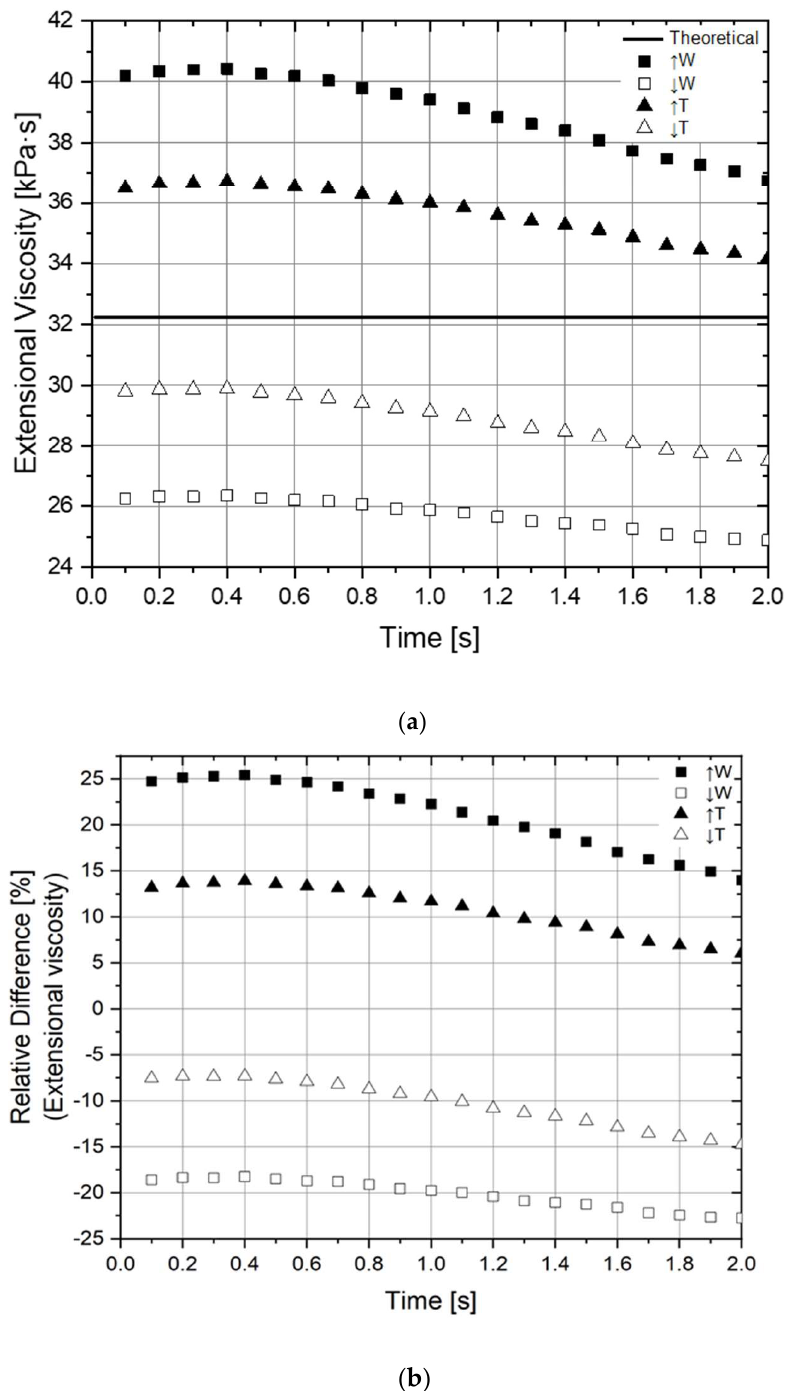
Figure 12. Results for the sample dimensions errors case studies: ( a ) extensional viscosity, ( b ) relative difference between theoretical and numerical viscosities.